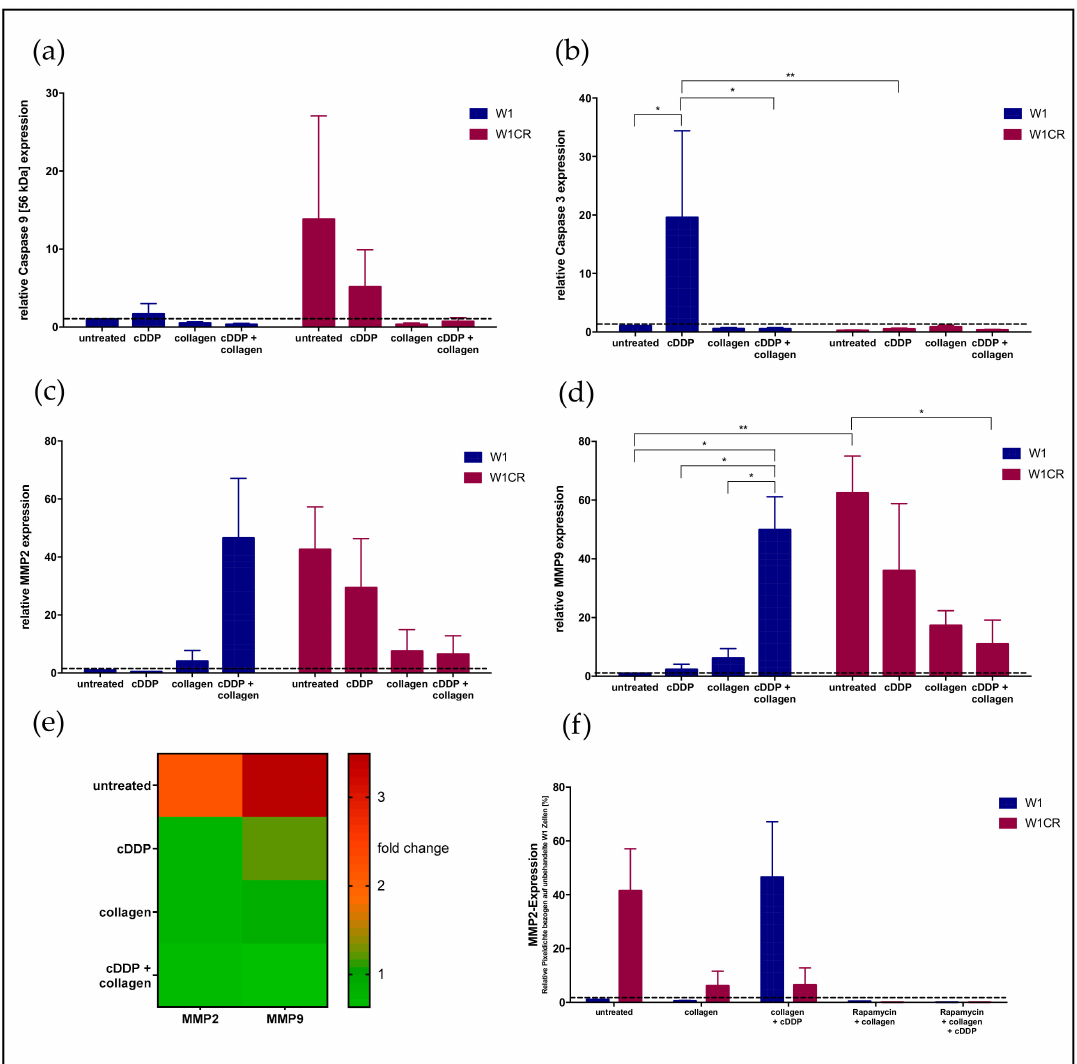
Figure 6. Protein levels of caspase 9 ( a ) and the downstream e ff ector caspase 3 ( b ) in W1 and W1CR cells upon the indicated treatment. Protein levels of MMP2 ( c ) and MMP9 ( d ) in W1 and W1CR cells reflected by the corresponding mRNA levels shown as comparison of W1CR cells versus W1 cells ( e ). ( f ) MMP2 expression levels in W1 and W1CR cells and the impact of a pretreatment with rapamycin thereon. Data are means of at least n = 3 ( ± SEM), asterisks indicate statistical significance: * p < 0.05; ** p <